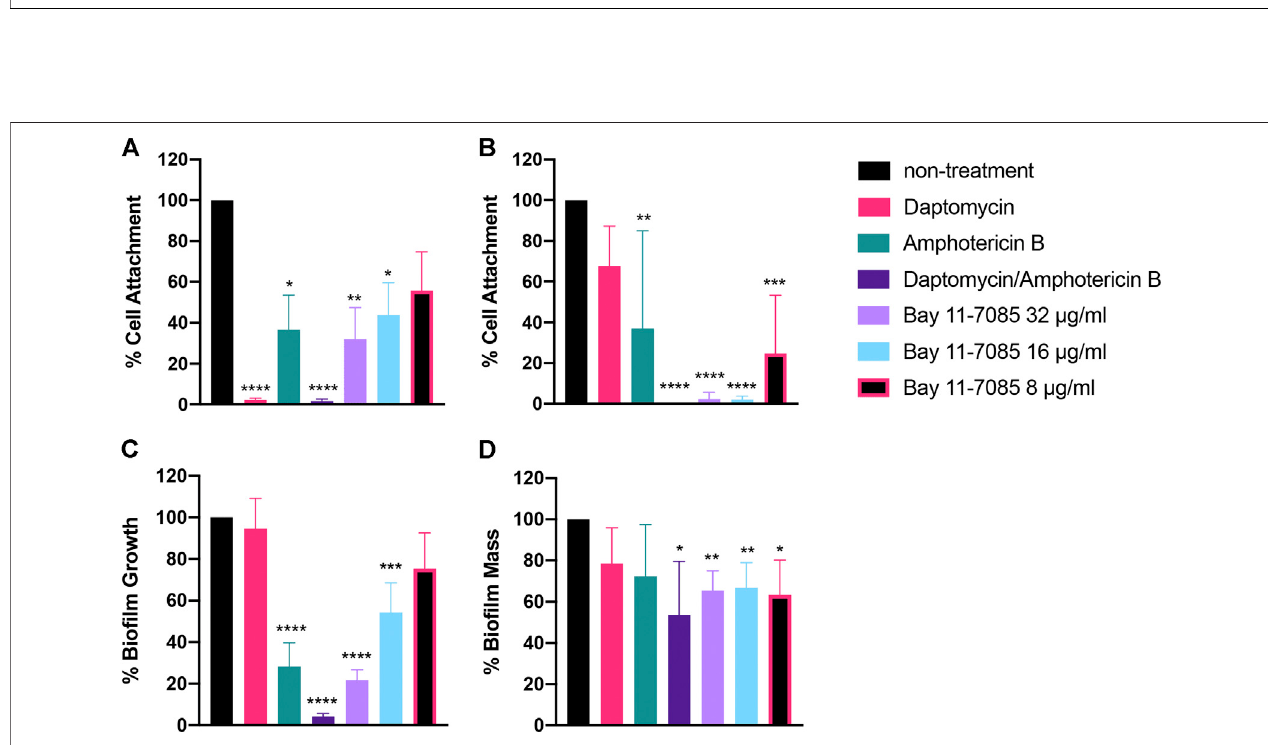
FIGURE 7 | Bay 11-7085 shows anti-bio fi lm activity towards three phases of S. aureus-C. albicans polymicrobial bio fi lm maturation. Activity of Bay 11-7085 at variousconcentrationswastested against S.aureus VRS1- C. albicans SC5314polymicrobial bio fi lminitialcellattachment,maturation, and eradication. S.aureus strain VRS1and C.albicans strainSC5314weregrownovernightinBHIorYPDmediumrespectively.Cellswerewashedandco-culturedata1:10ratio S.aureus strainVRS1 to C. albicans strain SC5413 under treatment of daptomycin 8 × MIC (8 μ g/ml), amphotericin B 32 × MIC (16 μ g/ml), a combination of both daptomycin and amphotericin B and Bay 11-7085 at 36, 16, and 8 μ g/ml. Percent cell attachment was normalized to non-treatment control for (A) S. aureus strain VRS1, and (B) C. albicans strain SC5413 after treatment. Bay 11-7085s activity on S. aureus VRS1- C. albicans SC5314 bio fi lm inhibition (C) and eradication (D) of mature bio fi lm was measured using 1% CV. Statistical signi fi cance was determined using one-way ANOVA with Dunnett ’ s test for multiple comparisons (A – C) or Unpaired t -test (D) . * p < 0.05; ** p < 0.01; *** p < 0.001; **** p < 0.000.1. ( n (cid:2) 3, ± S.D.).